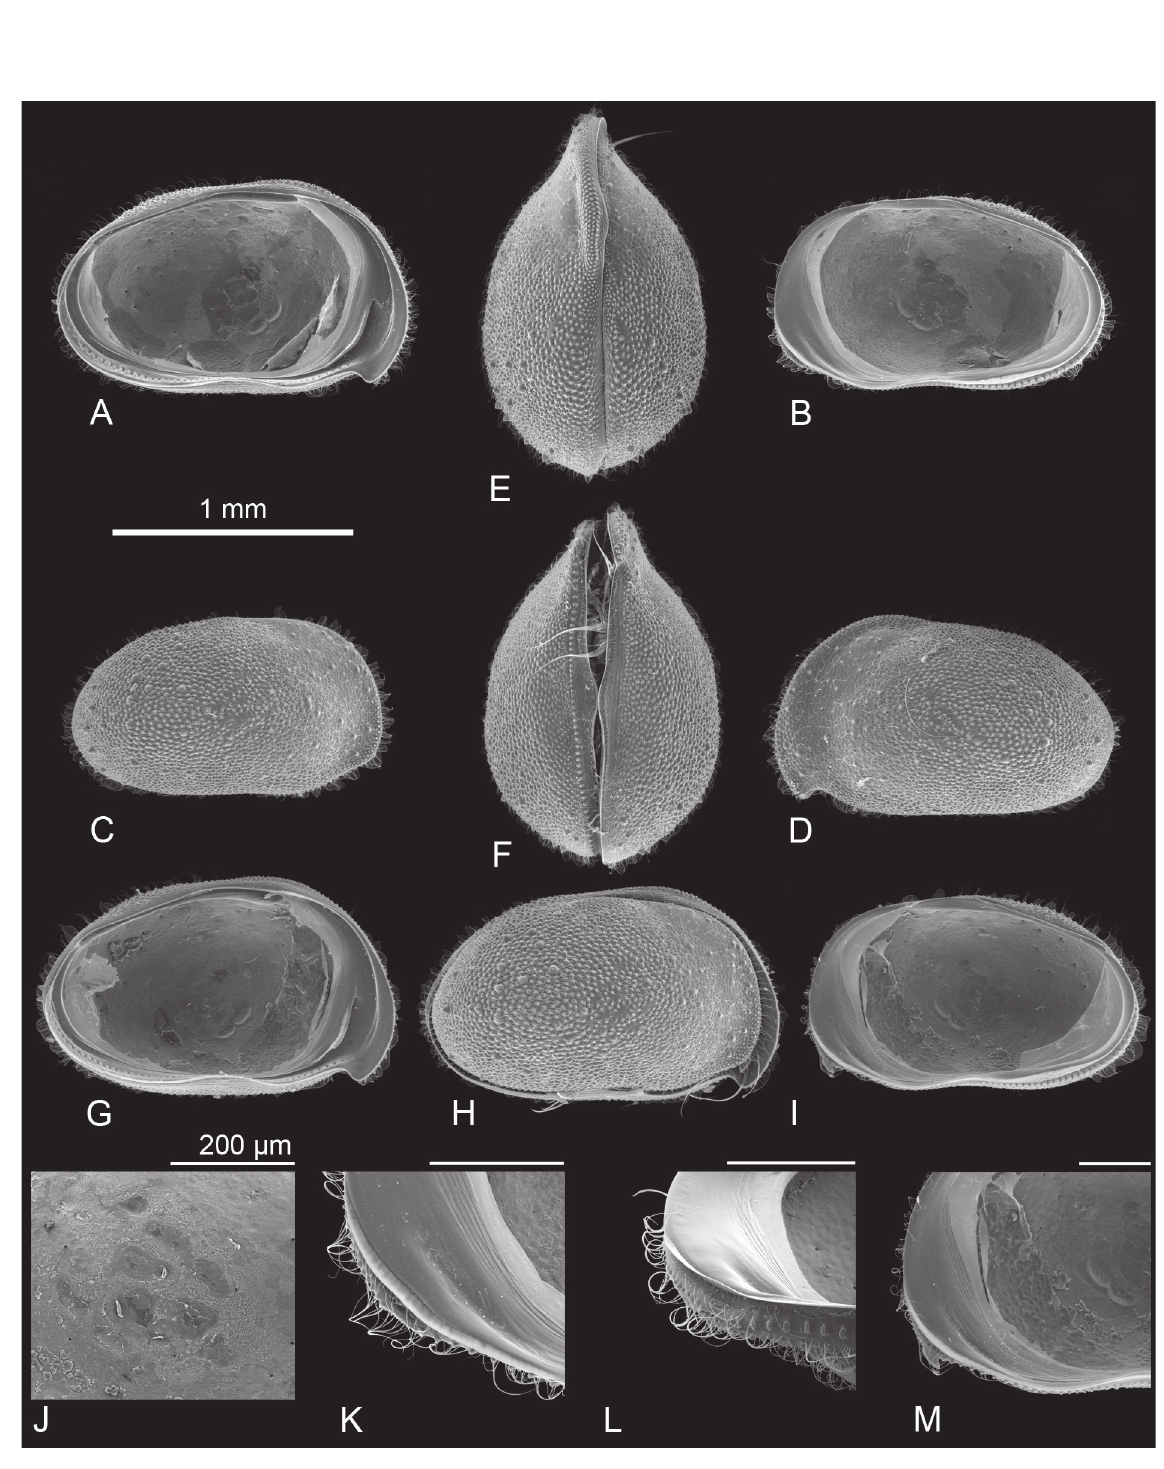
Fig. 10. Bennelongia shieli sp. nov. (all ♀, all from type locality: Munreemya Billabong, Pilbara, WA). A . LVi (holotype, WAMC55626). B . RVi (WAMC55626). C . RVe (WAMC55627). D . lVe WAMC55627). E . CpD (WAMC55628). F . CpV (WAMC55629). G . LVi (WAMC55630). H . cprl (OC3379). I . RVi (WAMC55630). J . RVi, detail central muscle scars (WAMC55627). K . rVi, detail anterior margin (WAMC55626). L . RVi, tilted, detail anterior margin (WAMC55626). M . rVi, detail anterior margin (WAMC55630, aberrant specimen). Scales = 1 mm for A–I; 200 µm for